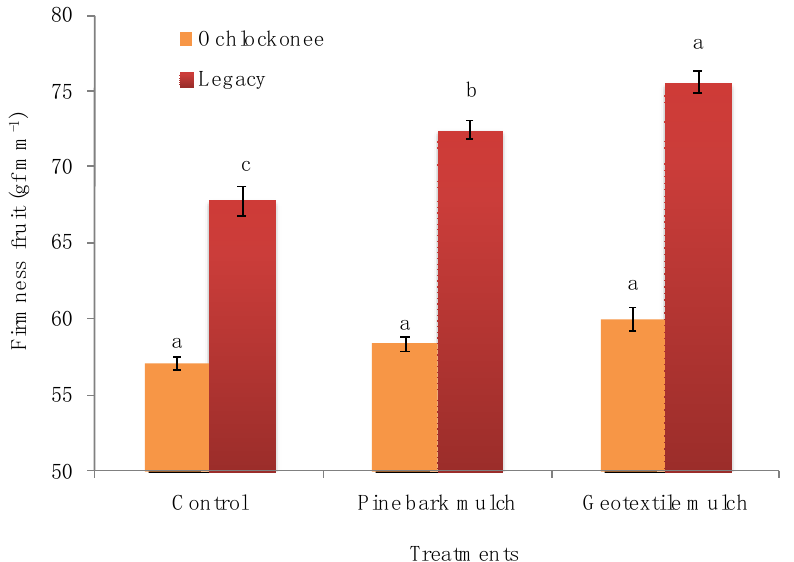
Figure 7. Effects of the different types of mulch on the firmness of the fruit. For each cultivar, different lowercase letters indicate significant differences for different types of mulch, according to the Tukey test ( p < 0.05). The vertical bars correspond to ± the standard error of the mean ( n = 9).